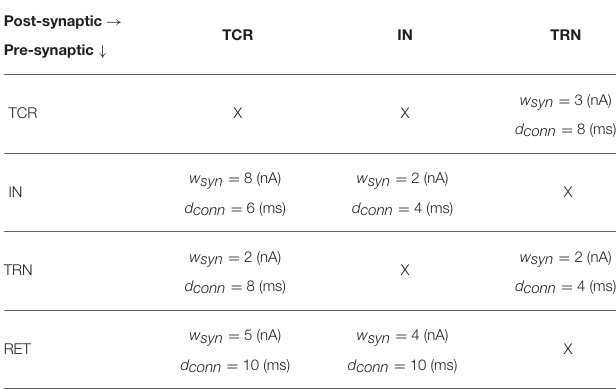
TABLE 3 | The synaptic weights w syn in the model are parameterized so as to be above the minimum threshold for spiking corresponding to a Poisson train input, the corresponding thresholds for periodic spike-train inputs being comparatively